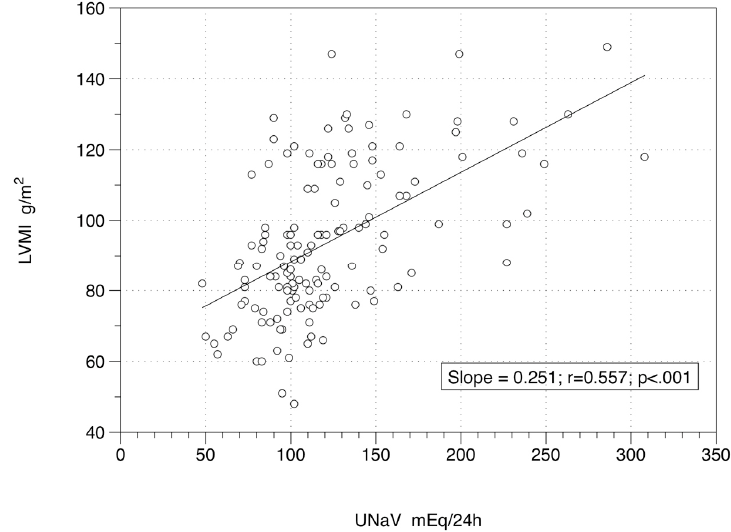
Figure 2. Relationship between left ventricular mass index and 24-h sodium excretion at end of study. Figure 2 Legend: 138 patients under active drug treatment at Time 2, two years after a low-sodium diet was administered. Equation of the regression line is y = 62.97 + 0.25x. UNaV: 24-h urinary sodium (excretion); LVMI: left ventricular mass